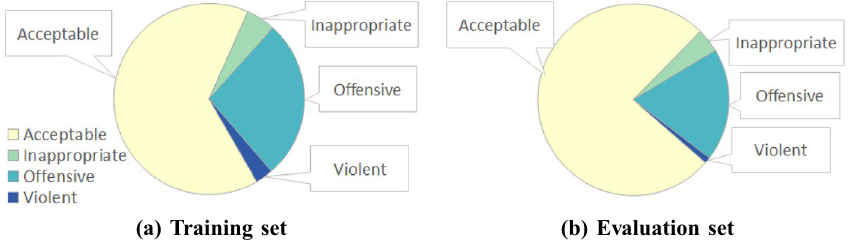
Figure 1. The distribution of the four hate speech labels in the manually annotated training ( a ) and evaluation ( b ) sets. The training set is intentionally biased to contain more hate speech while the evaluation set is